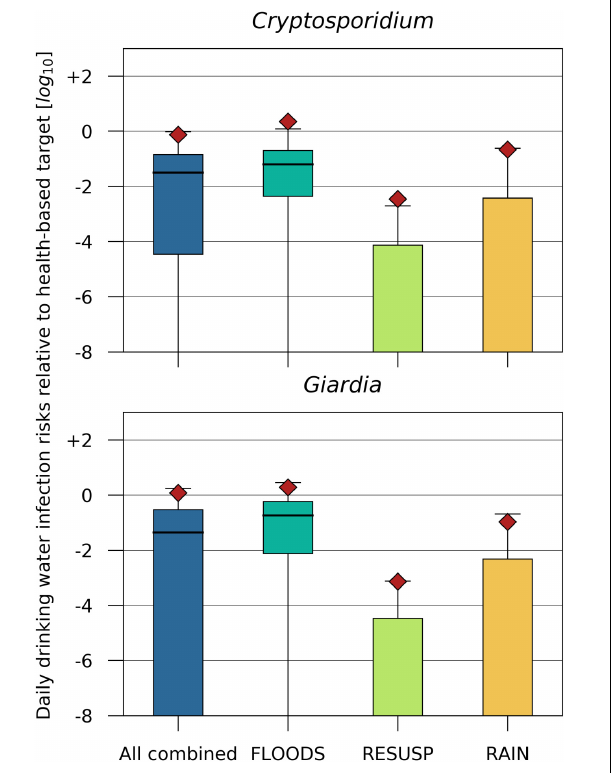
FIGURE 9 | Cryptosporidium and Giardia daily drinking water infection risks relative to a health-based benchmark of –6 log 10 /person/d (Signor and Ashbolt, 2009) for the scenarios (i) discharge of Danube water (FLOODS), (ii) resuspension from fecal deposits in inundated areas (RESUSP), (iii) rainfall-release and runoff from fecal deposits (RAIN), and all scenarios combined during 2010–2015. The treatment reduction of Cryptosporidium and Giardia from backwater river water (LRV, Equation 13) was 6.2 and 6.0 log 10